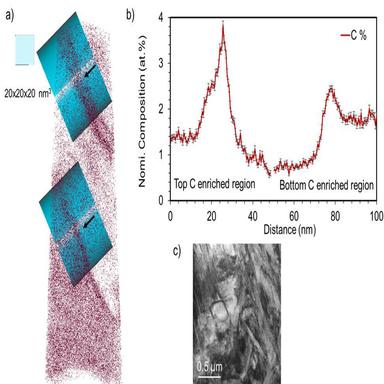
Carbon distribution map from as-sintered H13 sample with 85% biner saturation showing the carbon segregation on lath boundaries using (a) 3D atom maps and (b) 1D concentration profile across the lath boundaries. The analysis direction is the same as the arrow. (c) STEM image shows the evidence of lath martensite.